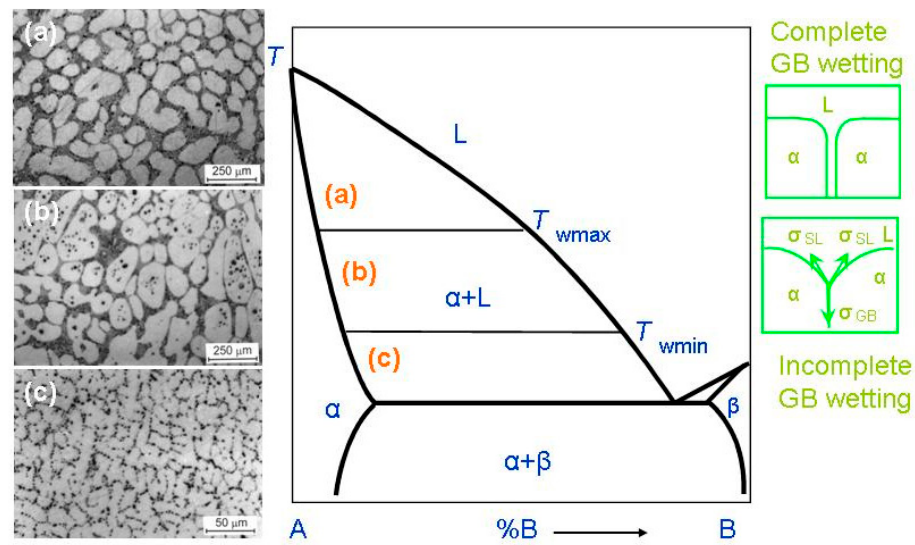
Figure 2. Binary A–B diagram of 3D phases for the discussion of the GB wetting phenomena. Thick lines (solidus, solvus, liquidus, eutectic lines) mark the bulk transitions between 3D phases. Thin lines at T wmin and T wmax mark the tie-lines for the wetting of α / α GBs by the liquid phase, L. On the left-hand side of the figure the micrographs are shown for the L + (Al) polycrystals containing liquid and solid phases. Case ( a ) shows the alloy structure above T wmax . Here, all (Al)/(Al) GBs are fully wetted. The scheme ( b ) shows the alloy structure between T wmax and T wmin . Here, some (Al)/(Al) GBs are completely wetted, and other (Al)/(Al) GBs are partially wetted. The scheme ( c ) shows the alloy structure below T wmin . This sample contains only partially wetted (Al)/(Al) GBs. The respective thermodynamic schemes for complete and incomplete GB wetting are shown right. Here, σ GB is the GB energy, σ SL is the IB energy, θ is the contact angle. The micrographs are reprinted with permission from ref. [60]. Copyright 2021 MDPI.